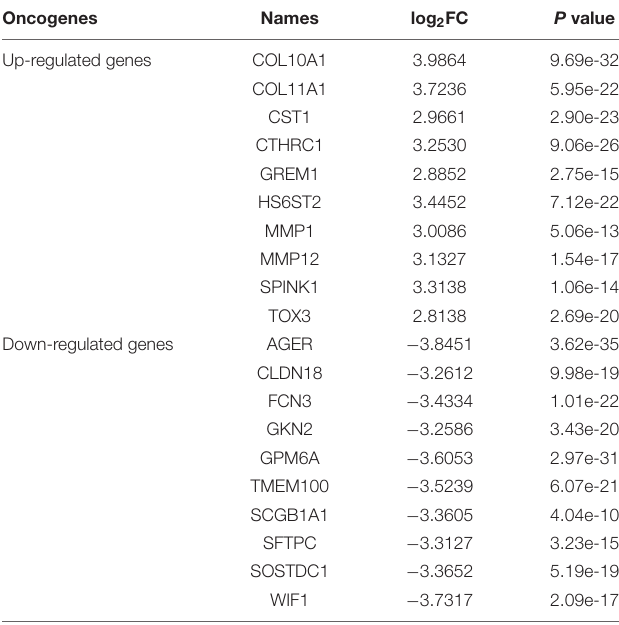
TABLE 2 | The log 2 FC values of first 10 up-regulated genes and first 10 down-regulated genes with relatively large differences. Oncogenes Names log 2 FC P value